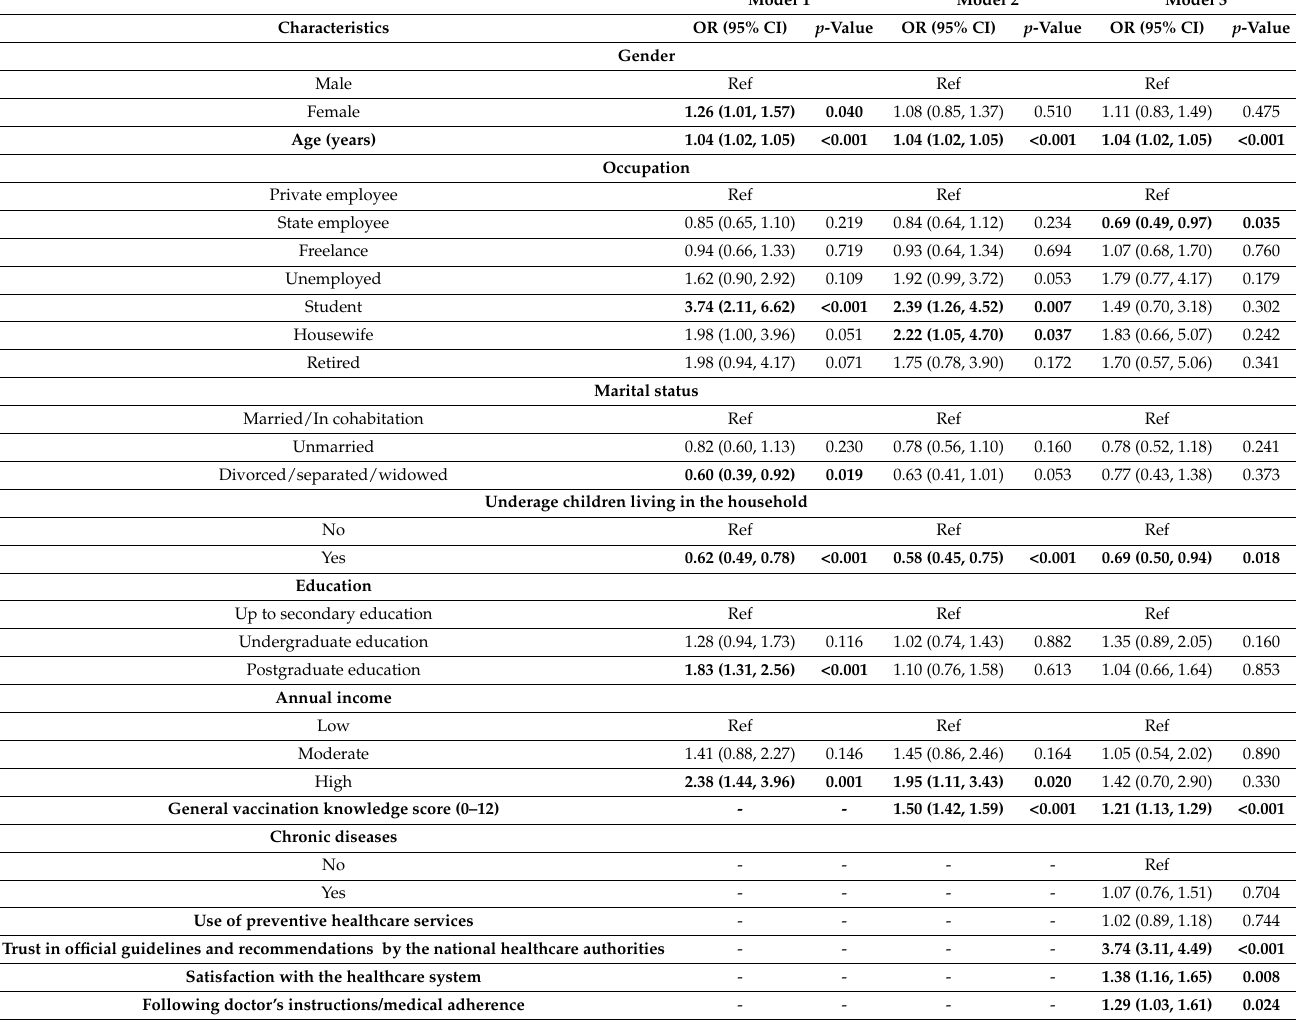
Table 5. Hierarchical logistic regression modeling for sociodemographic, vaccination knowledge score, and health status and attitudes towards healthcare services on mandatory vaccination